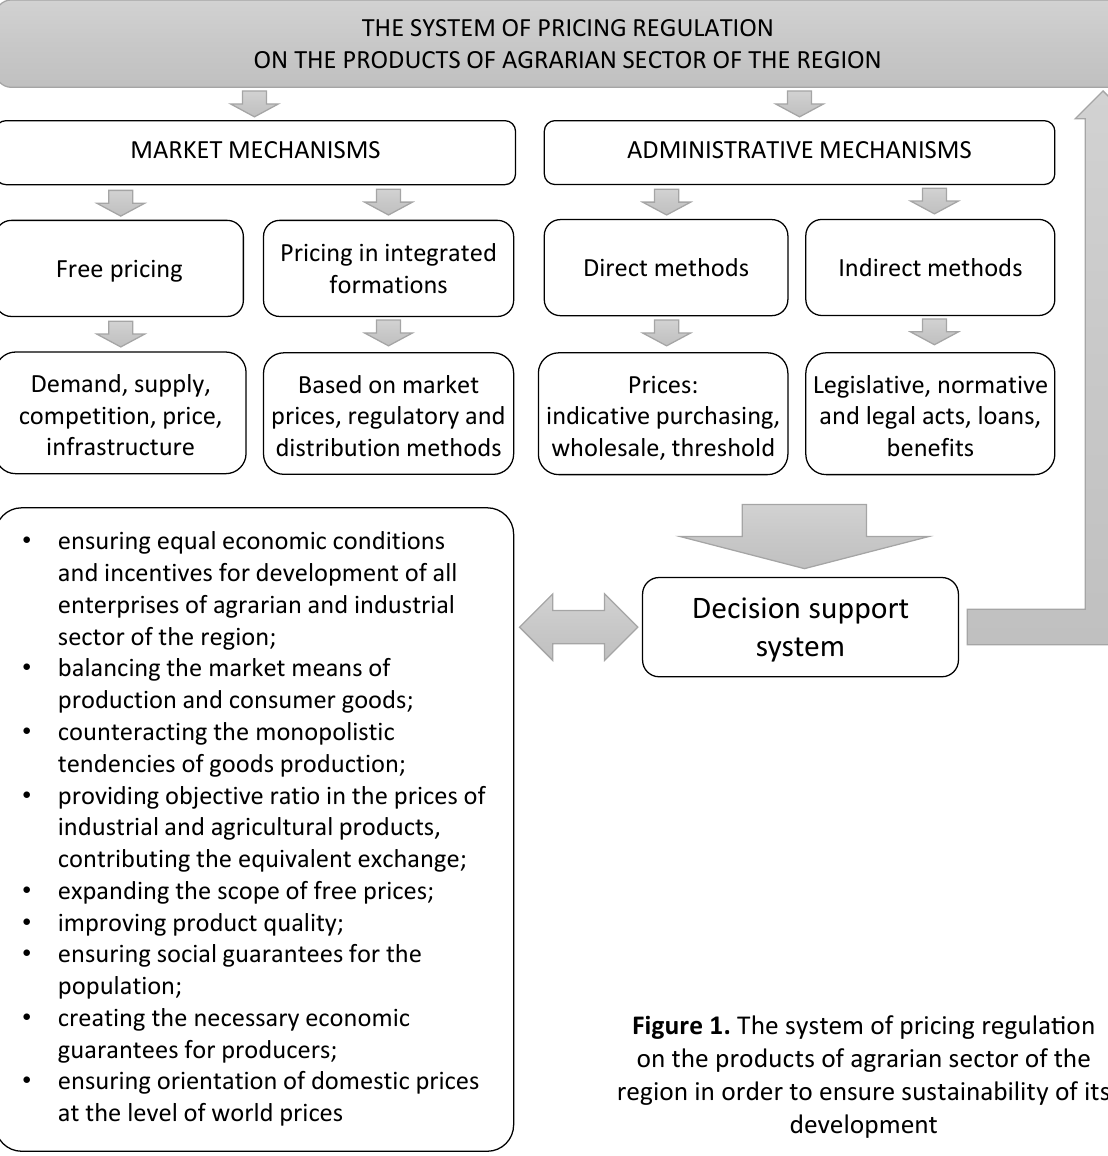
Figure 1. The system of pricing regulation on the products of agrarian sector of the region in order to ensure sustainability of its